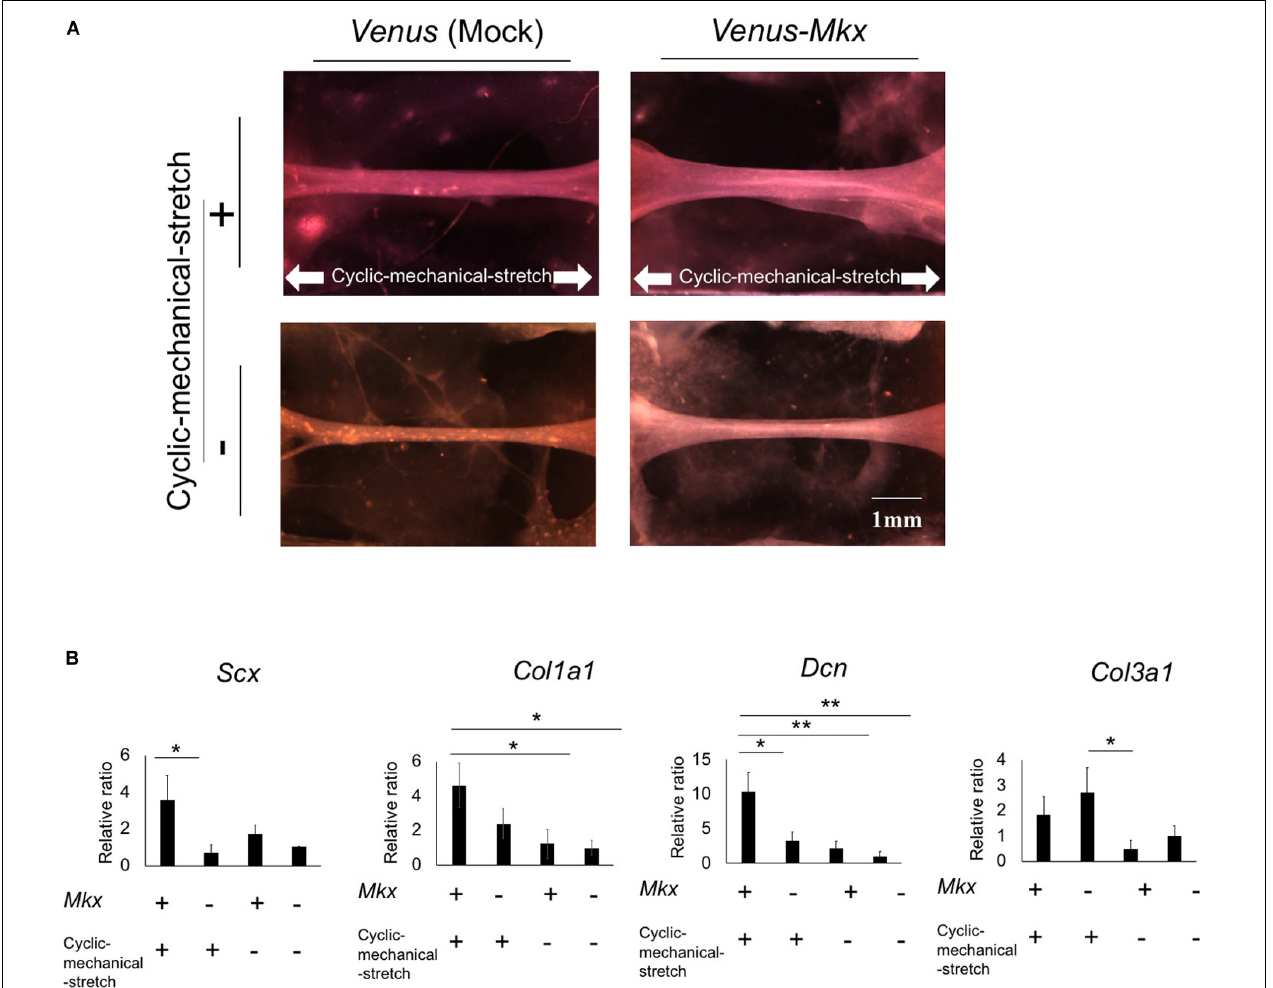
FIGURE 2 | Morphology and gene expression analysis of the tendon/ligament-like tissue under four different culture conditions. (A) The tendon/ligament-like tissue. These tissues were generated under four different culture conditions: Venus-Mkx –expressing mesenchymal stem cell (MSC) line C3H10T1/2 cells undergoing cyclic mechanical stretch (right top) (VMS+), Venus-Mkx –expressing C3H10T1/2 cells without cyclic mechanical stretch (right bottom) (VMS–), Venus (Mock)-expressing C3H10T1/2 cells undergoing cyclic mechanical stretch (left top) (VS+), and Venus (Mock)-expressing C3H10T1/2 cells without cyclic mechanical stretch (left bottom) (VS–) ( n = 3). The direction of the cyclic mechanical stretch load is represented by white arrows. Scale bar: 1 mm. (B) Quantitative real-time quantitative reverse transcription polymerase chain reaction (qRT-PCR) analysis of the expression of Scx , Col1a1 , Col3a1 , and Dcn . Gene expression levels are normalized to the reference gene ( Gapdh ). Error bars show the mean ± standard deviation ( n = 3). An asterisk represents the statistical significance calculated by Bonferroni test: * p < 0.05 (for expression of Scx ) and Tukey’s honestly significant difference (HSD) test: * p < 0.05 and ** p < 0.01 (for expression of Col1a1 , Col3a1 , and Dcn